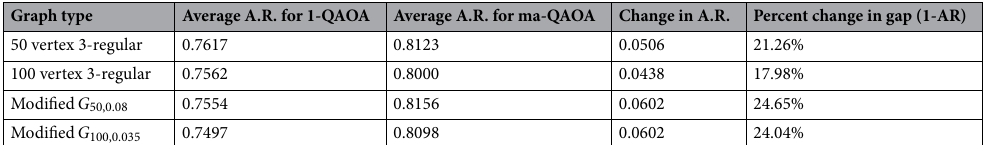
Table 1. The average approximation ratio (A.R.) for a collection of one-hundred 3-regular graphs with fifty vertices, one-hundred 3-regular graphs with 100 vertices, fifty modified G 50,0.08 random graphs, and fifty modified G 100,0.035 random graphs.